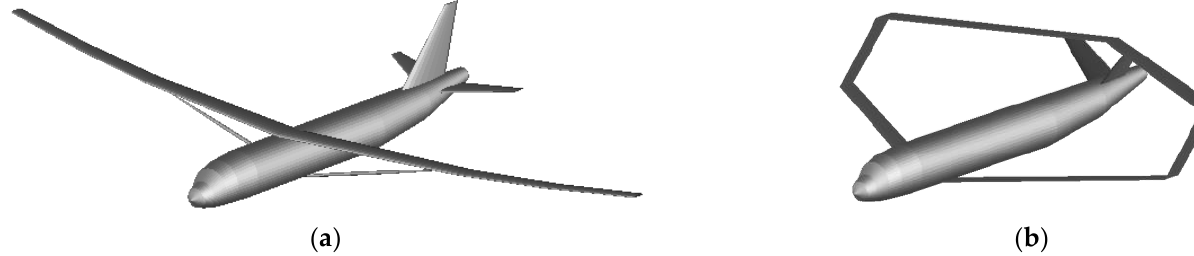
Figure 3. ( a ) Strut-braced and ( b ) box wing configurations designed in OpenVSP based on A320 design (adapted from [24]).